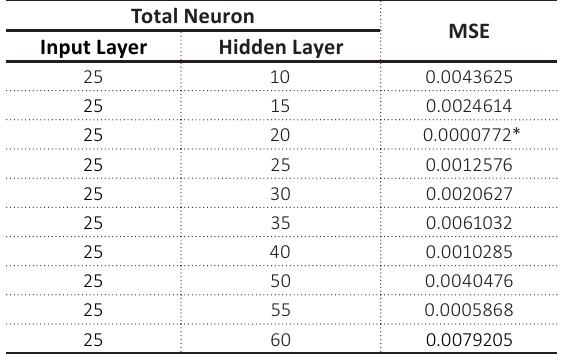
Table 4. Comparison of combined MSE